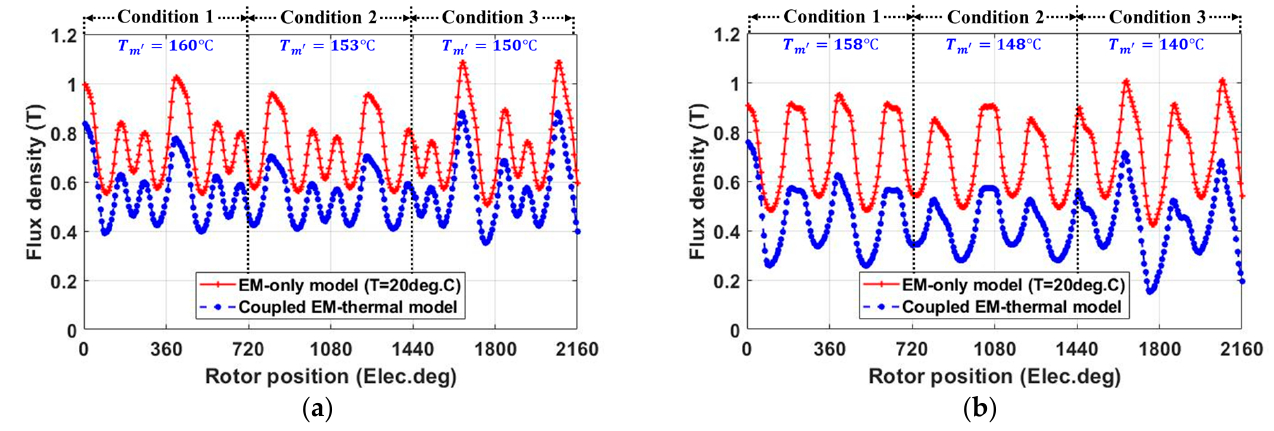
Figure 16. Magnet flux density variation under different operating conditions calculated for ( a ) modular and ( b ) non-modular machines. T m ′ denotes the average magnet temperature.